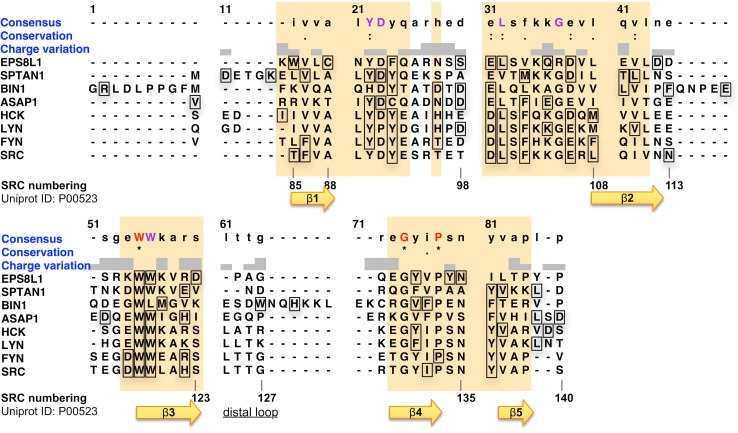
Structural alignment of the SH3 domain variants, with consensus sequence, conservation, and charge variation annotations (illustration provided by Chimera [41]).On top of the alignment, the 15 top-ranking residues are annotated with squares around the amino acid residues. This limit is arbitrary and purely used here for illustration purposes. The regions for which the structural alignment can be considered most reliable are highlighted in orange (see Material and Methods). The Src SH3 numbering from the Uniprot entry P00523 is also reported for reference at the bottom of the alignment, together with the Src SH3 secondary structure annotation.